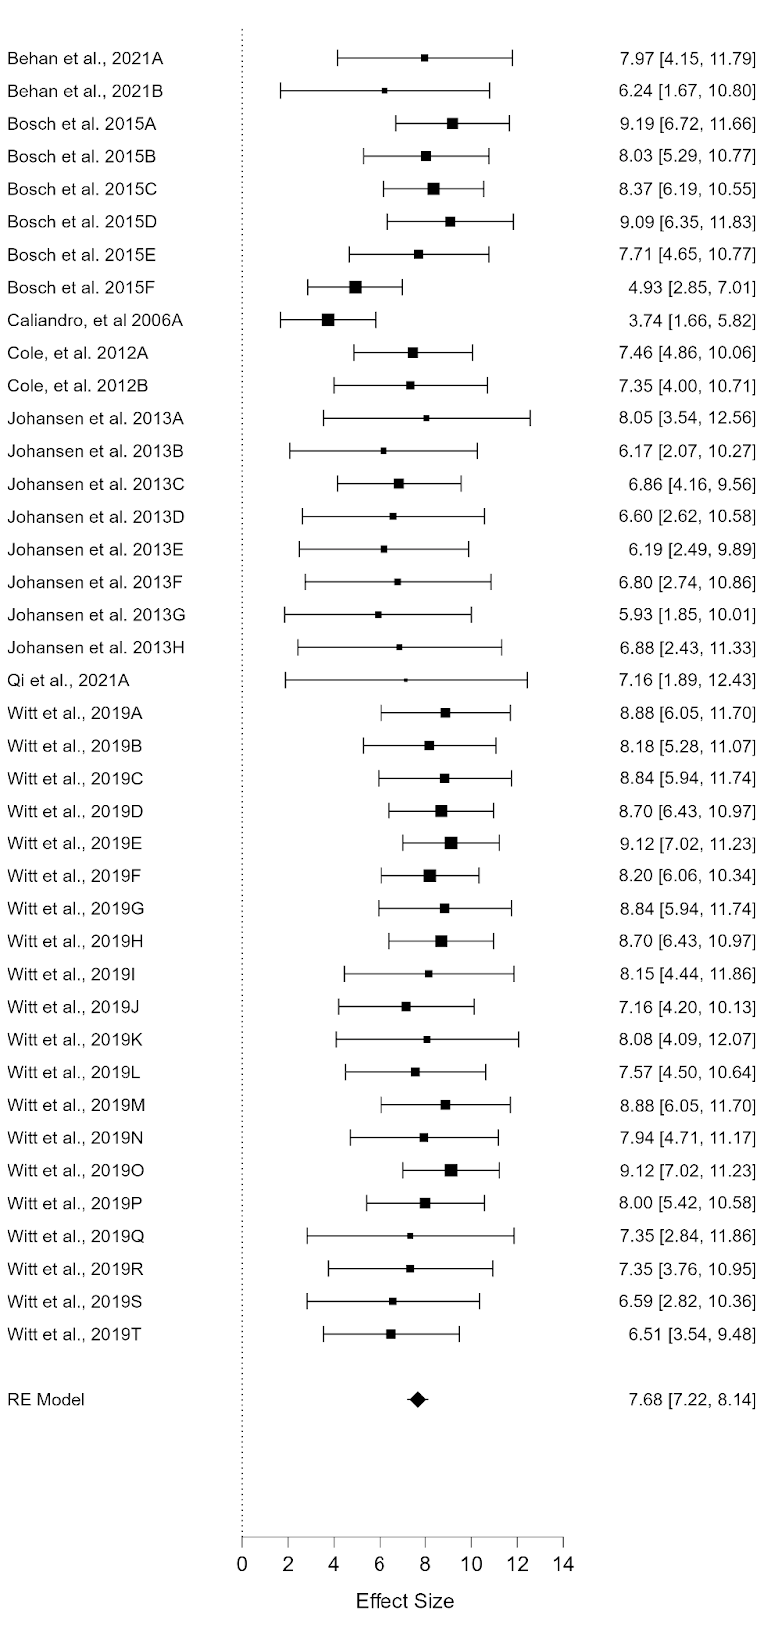
Figure 2. Forest plot of social subscale [16–22]. Note: Each sample represented on the right-side effect size (lower limit, upper limit).